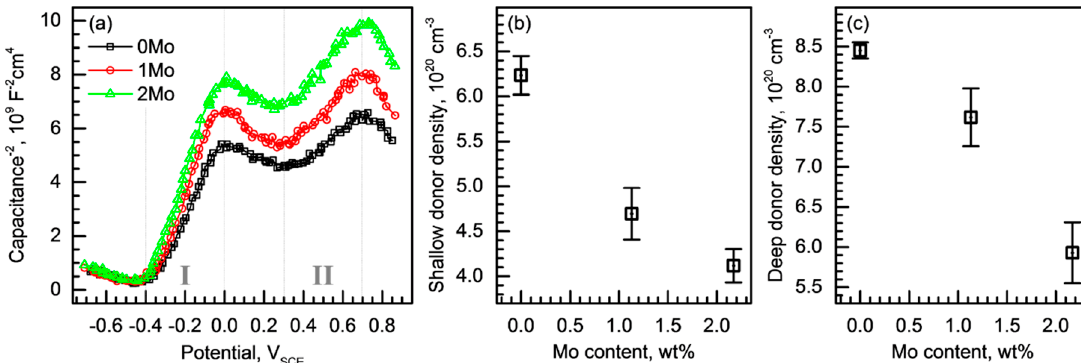
Figure 6. ( a ) Mott-Schottky plots of 0Mo, 1Mo, and 2Mo alloys measured in a borate-phosphate-citric buffer solution (pH 8.5) at 25 °C with decreasing applied potential by imposing sinusoidal voltage buffer solution (pH 8.5) at 25 ◦ C with decreasing applied potential by imposing sinusoidal voltage perturbation (±10 mV) at a frequency of 1000 Hz. Average ( b ) shallow donor ( V O2+ ) density and ( c ) perturbation ( ± 10 mV) at a frequency of 1000 Hz. Average ( b ) shallow donor ( V O 2+ ) density deep donor (Cr 6+ ) density with standard deviation (scatter band) in the passive films of the alloys.